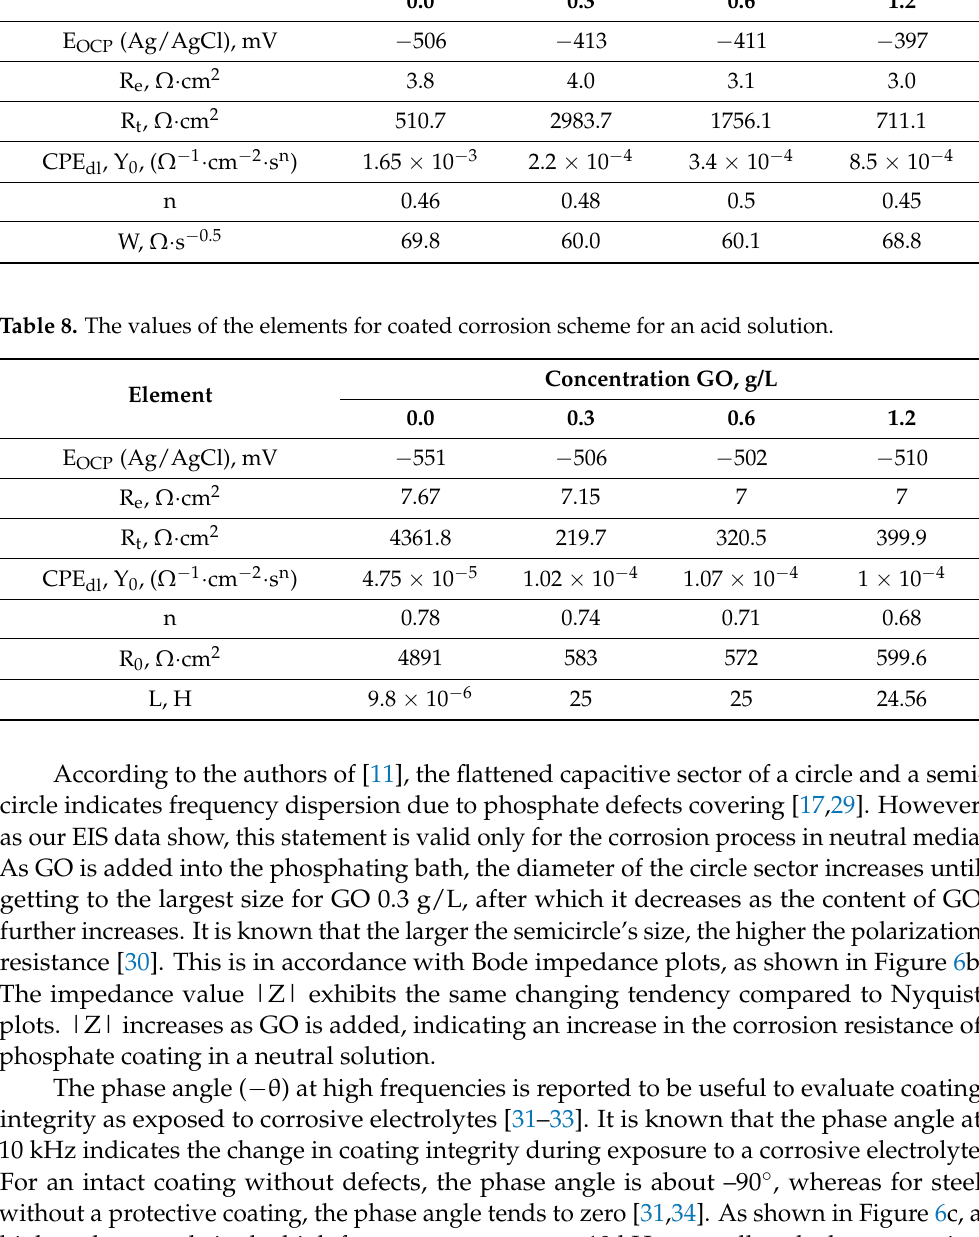
Table 7. The values of the elements for coated corrosion scheme for a neutral solution. Element